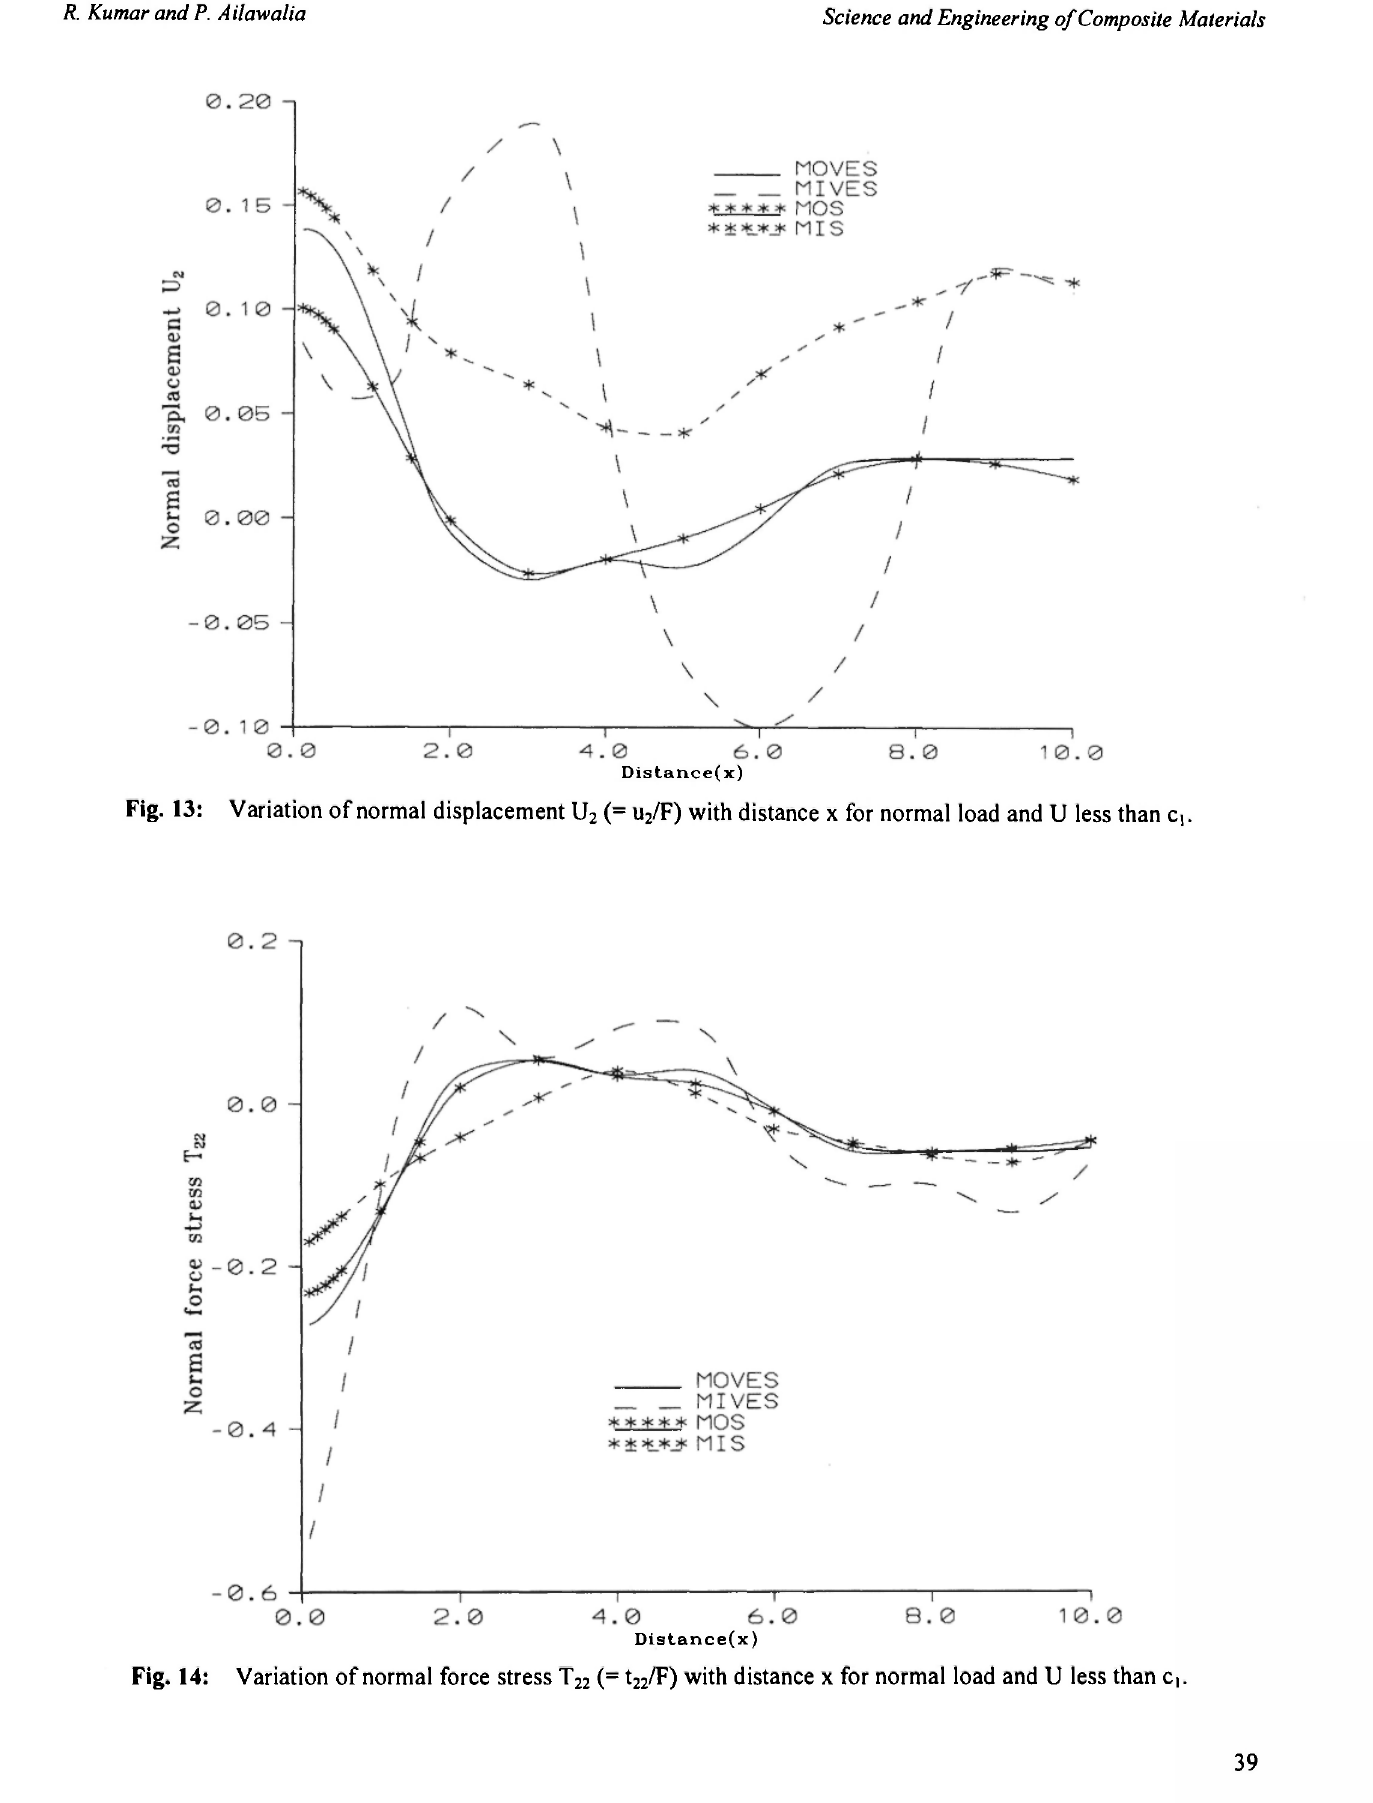
Fig. 14: Variation of normal force stress T 22 (= t 22 /F) with distance χ for normal load and U less than